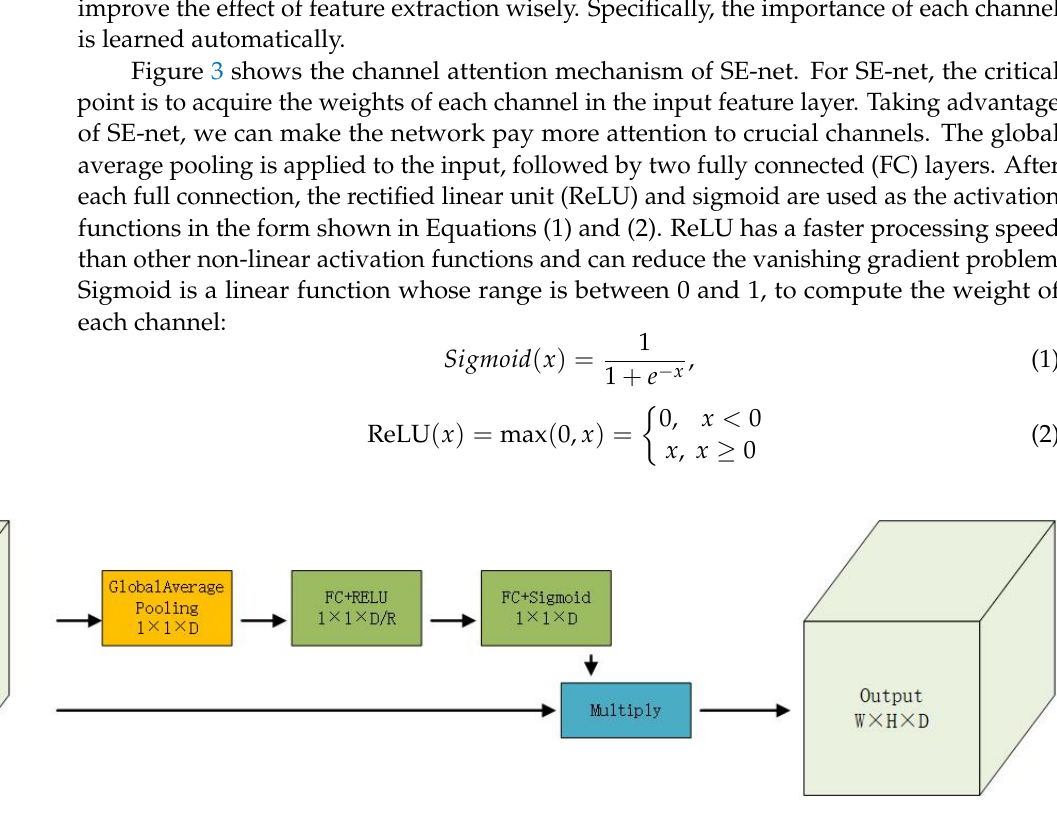
Figure 2. Two-dimensional convolution process and three-dimensional convolution process.